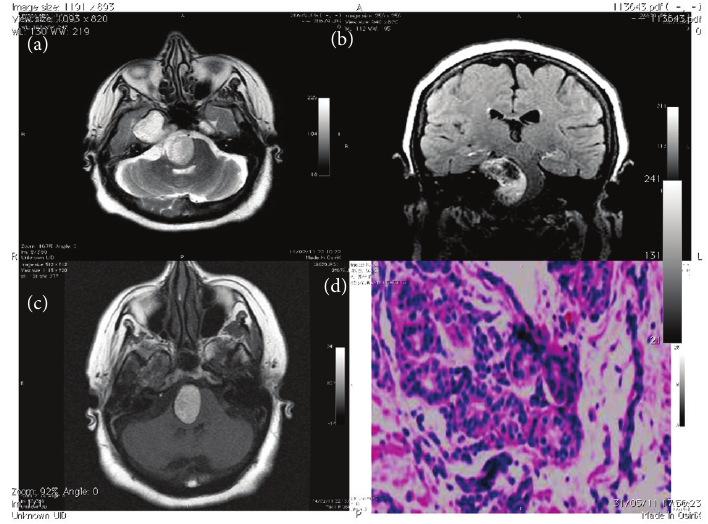
F 2: Axial FSE T2-w showed hyperintense lesion involving media and posterior fossa (a); coronal FLAIR showed a marked displaced brainstem by the lesion that resulting in the cranial portion disomogeneus hypo/hyperintense (b); axial SE T1-w showed marked hyperintense signal originating by caudal portion of the lesion (c); the histological sample obtained by biopsy showed recent and previous bleeding; hemosiderin pigments are well apparent